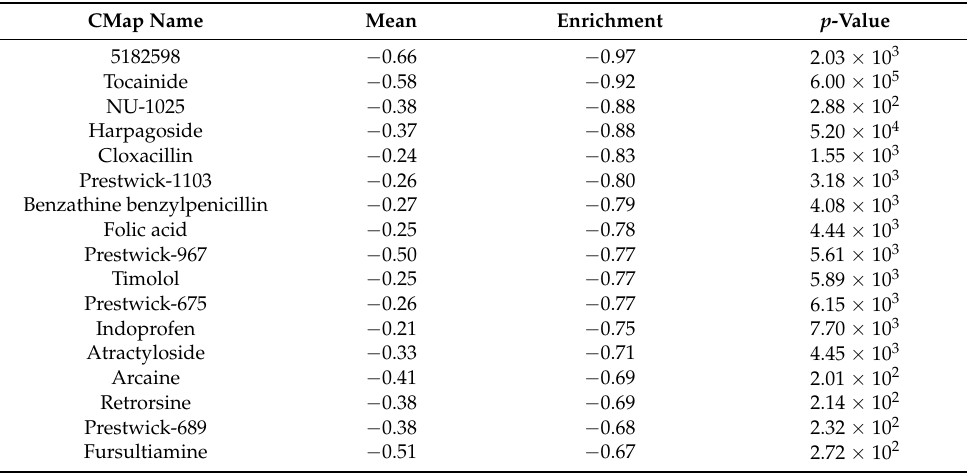
Table 6. Potential drugs that reversed the expression of genes induced by nanoparticles.